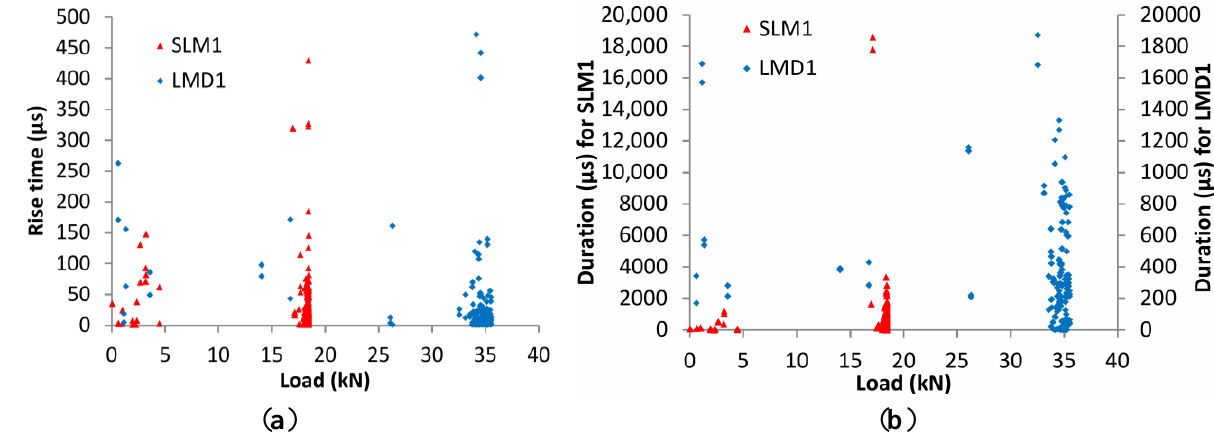
Figure 9. ( a ) Rise time vs. load history for SLM1 and LMD1 specimen; ( b ) duration vs. load history for SLM1 and LMD1